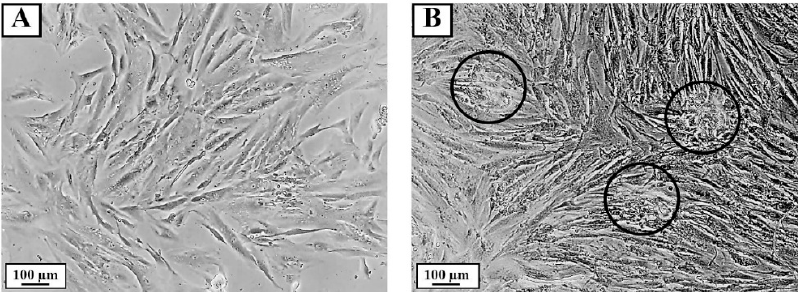
Figure 5. Effect of PPE on the aggregation of HFDPC cells after treatment for 72 h. HFDPC cells were treated with ( A ) DMEM (control group) and ( B ) 1000 µg/mL PPE. The images were photographed using an inverted microscope (10× objective lens, bright field).